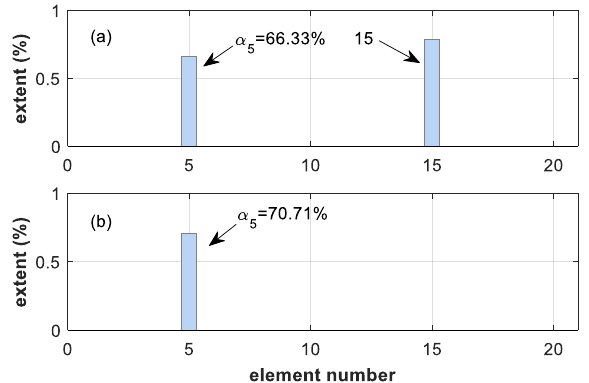
Figure 23. Damage identification results of damage case II, with an iterative Tikhonov solution: ( a ) CMSE method; ( b ) RCMSE method.